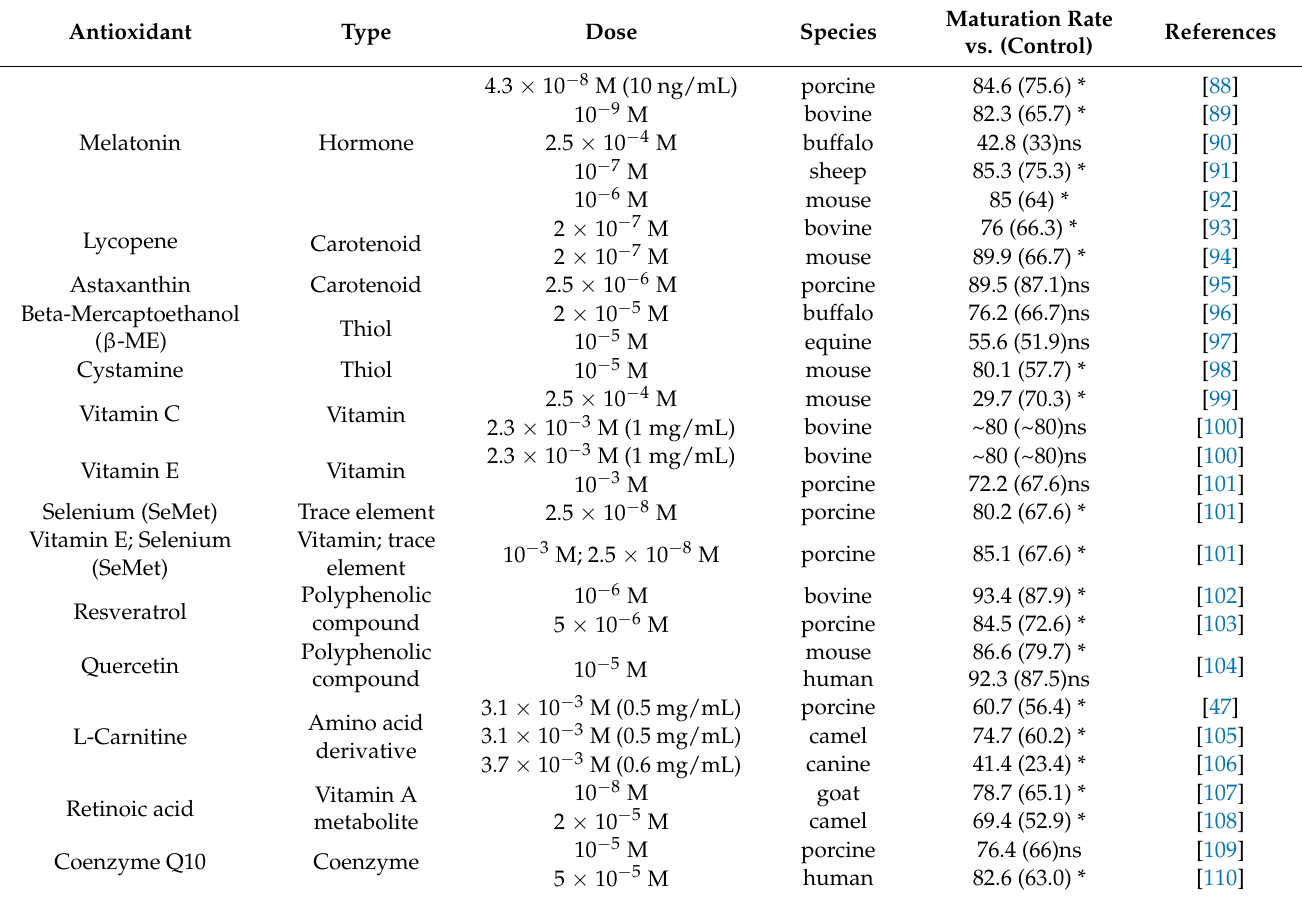
Table 1. List, concentrations, and effects of antioxidants used to improve in vitro maturation of oocytes in different